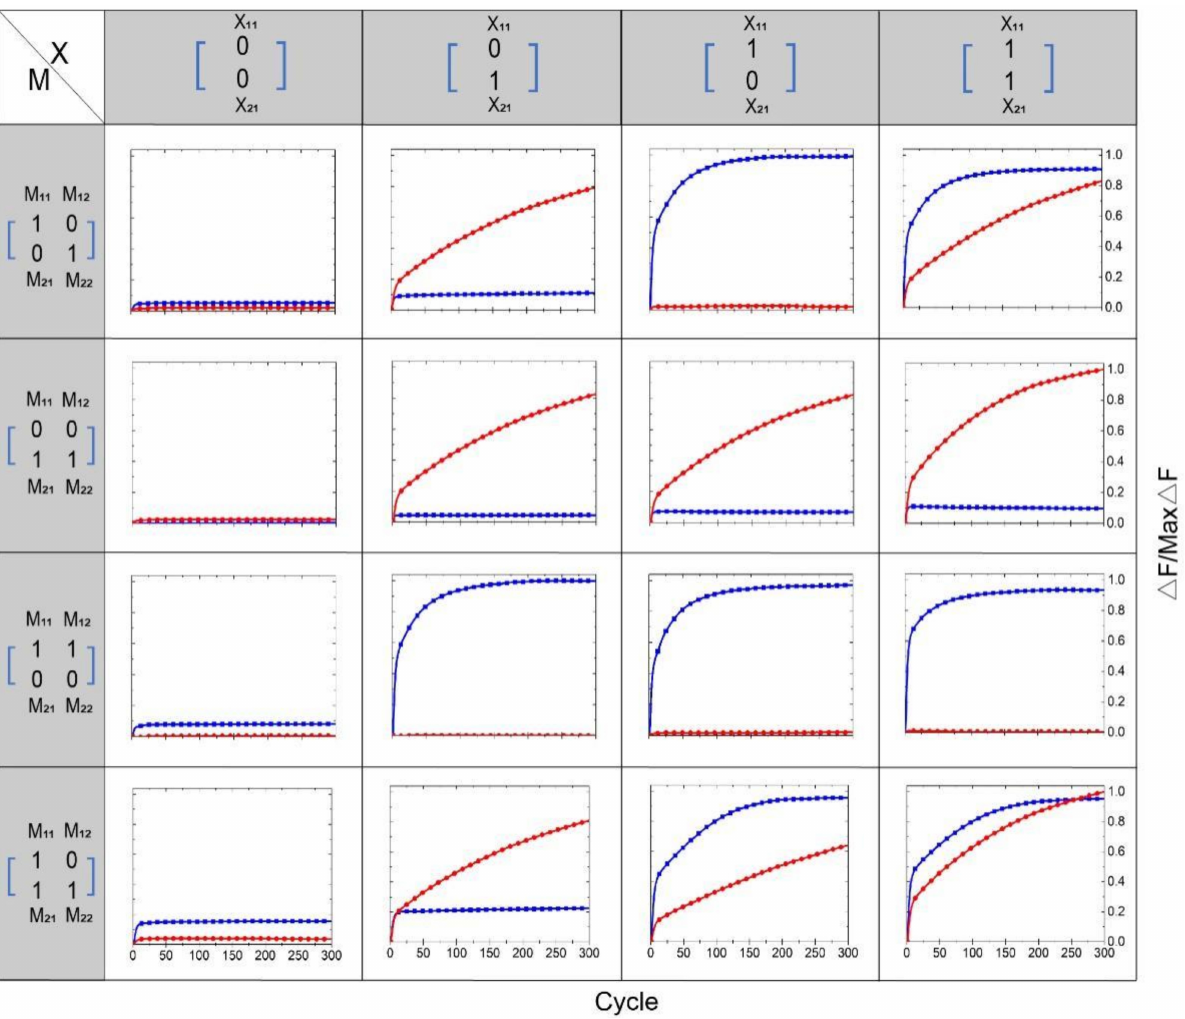
Figure 5. Results of 16 independent experiments. Before adding the element strands of the two matrices, the two DNAzymes and the two substrate strands of the reporting module are mixed. The sampling interval is 4 min, 300